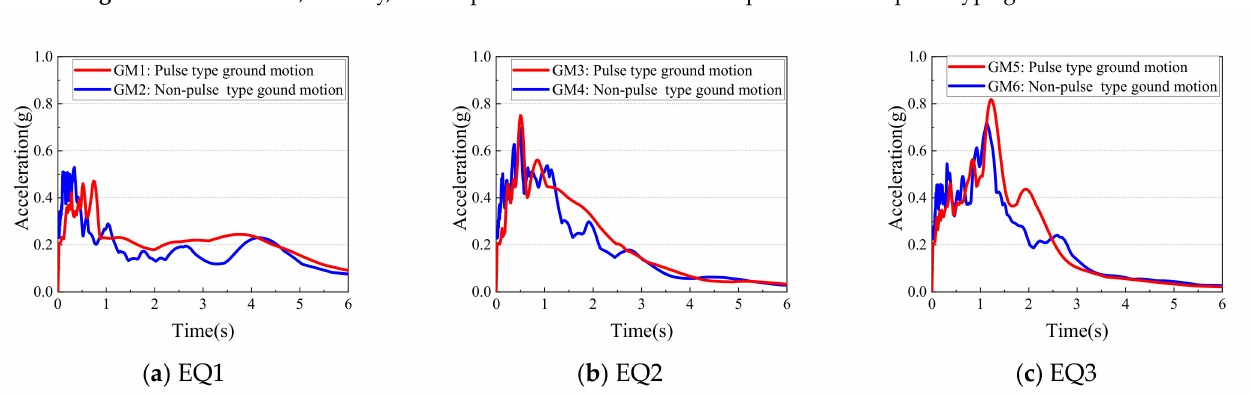
Figure 6. Acceleration response spectra of pulse and non-pulse type ground